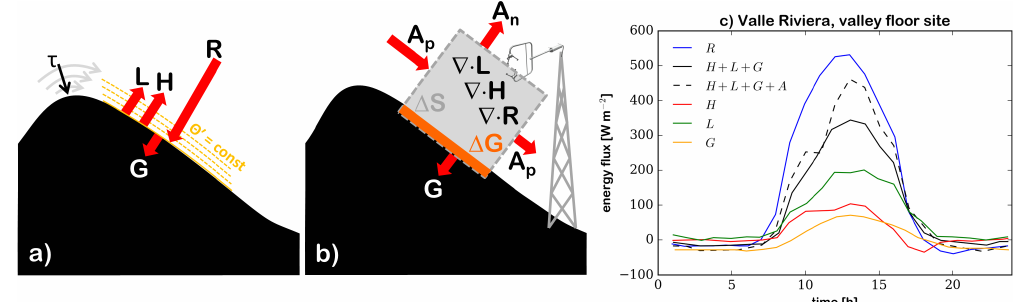
Figure 1. The surface energy balance in complex terrain (adapted from [56–58]). ( a ) The components of the budget are R (net radiation), H (sensible heat flux), L (latent heat flux), and G (ground heat flux). In the ideal case, the energy balance refers to the interface between the atmosphere and the ground. Because an ideal surface has no mass and cannot store energy, the balance is closed. Since perturbation isentropes are generally parallel to the ground, the most appropriate reference frame for eddy-covariance measurements has one axis normal to the ground [58]. Flux components along the other axes are not negliglible in general. The same considerations apply to the Reynolds stress ( τ ). ( b ) In practice, the experimental characterization of the energy balance refers to a sampling volume. Energy conservation implies that ∆ S + ∆ G = − ( ∇ × L + ∇ × H + ∇ × R + ∇ × A ) . A represents the advective flux, while ∆ S and ∆ G represent storage in the atmosphere and in the ground. Imperfect estimation of the storage terms and of the flux divergences implies lack of closure. In particular, advection effects (represented by A p and A n in the figure, for the components parallel and normal to the surface, respectively) are generally neglected but can be important over heterogeneous terrain. ( c ) Daily cycle of the energy balance components at a measurement site at the floor of the Riviera Valley, averaged over 7 days with weak synoptic forcing [57]. Accounting for horizontal and vertical advection effects, estimated from nearby mesonet stations, reduces the underclosure of the energy balance (an estimation of ∆ G is included in G , while ∆ S is negligible in this